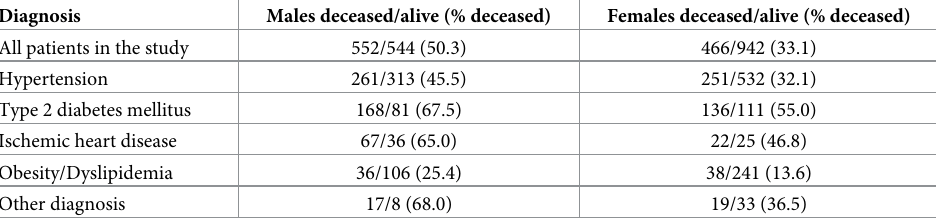
Table 2. Diagnosis for patients at time of admittance to the VPE-center and prevalence of deceased/alive with (%) presented for each sex. Diagnosis Males deceased/alive (% deceased) All patients in the